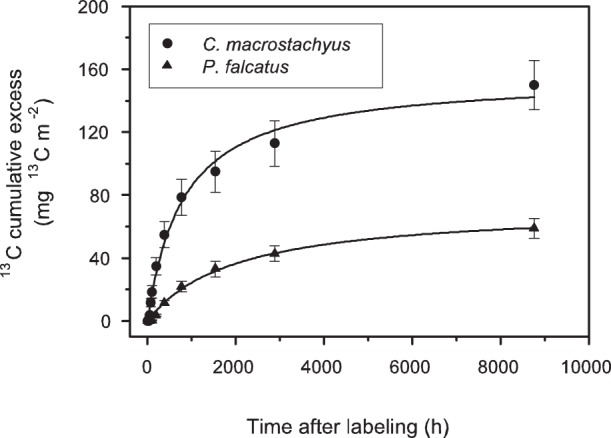
Time course of cumulative excess of 13C in soil CO2 efflux under Croton macrostachyus and Podocarpus falcatus during the one year chasing period.Data are means ± standard deviation (n = 5). The curves are fitted with a double exponential function for C. macrostachyus and a single exponential function for P. falcatus. Parameters are shown in Table 2.